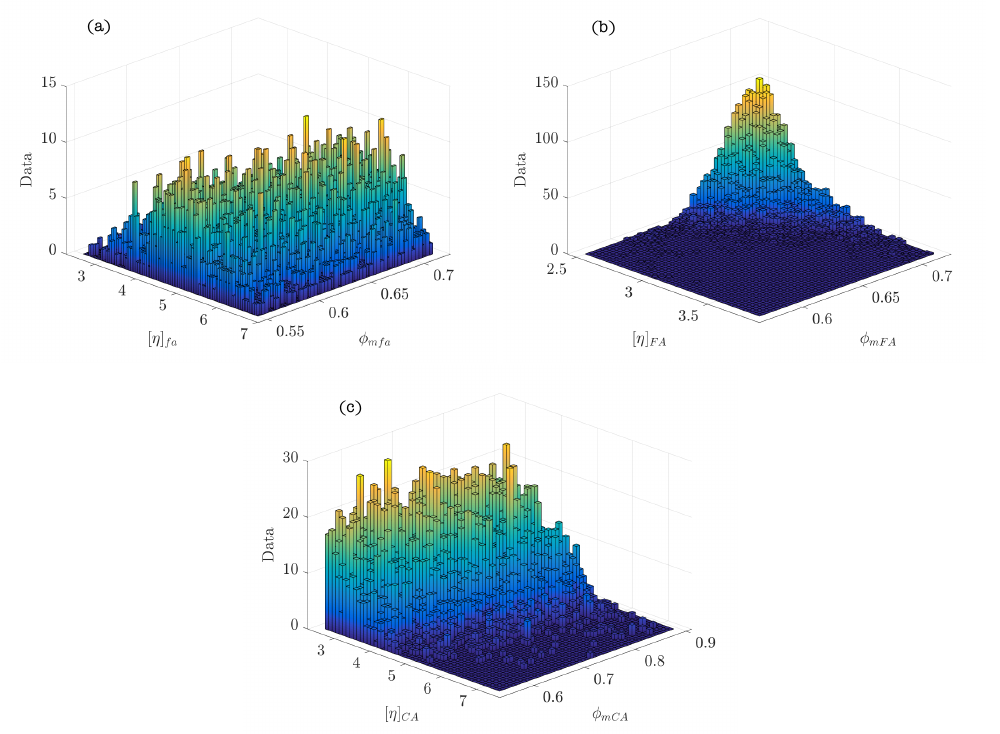
Figure 6. Bivariate histogram of φ mi and [ η ] i (( a ) powder phase; ( b ) fine granular phase; ( c ) coarse granular phase) composing SCSFRC ( λ